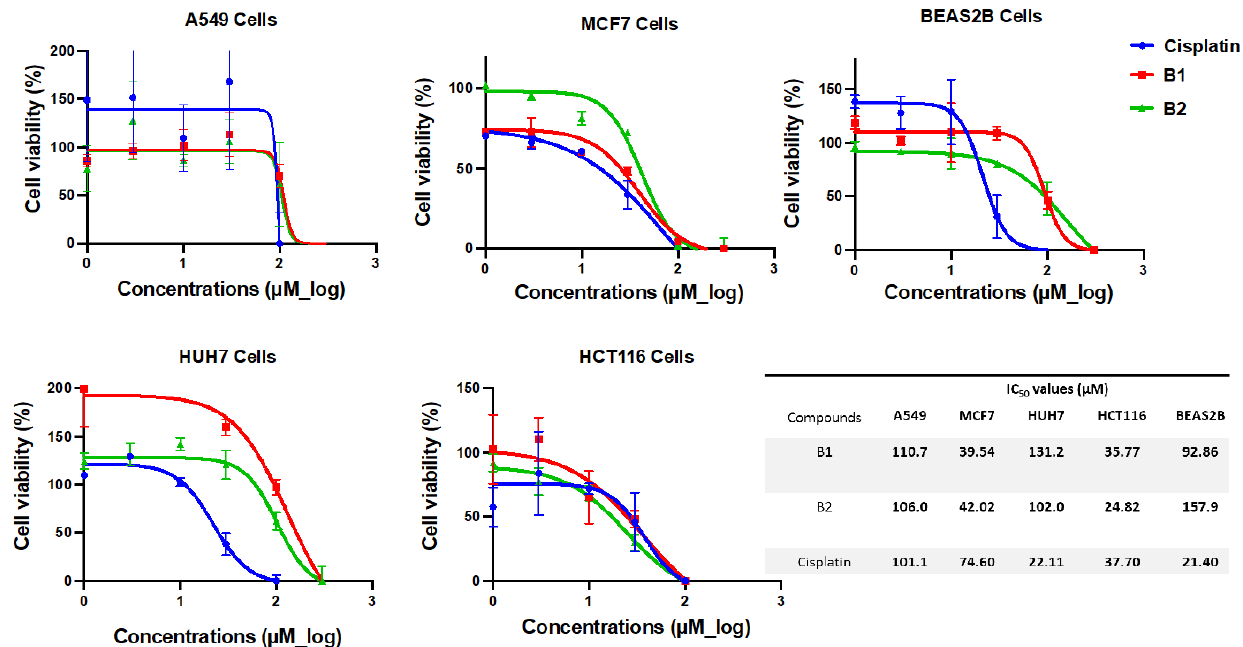
Figure 2. Cytotoxicity results of B1 and B2 on the A549, MCF7, HUH7, and HCT116, cancer cells, and BEAS2B normal lung cells. Cell viability assay was performed via a MTT protocol. Cells were treated with each compound at 0, 1, 3, 10, 30, 100, and 300 µM concentrations for 24 h. Graphs show the best curve fit of non-linear regression analysis. Calculated IC 50 values are given in the table.